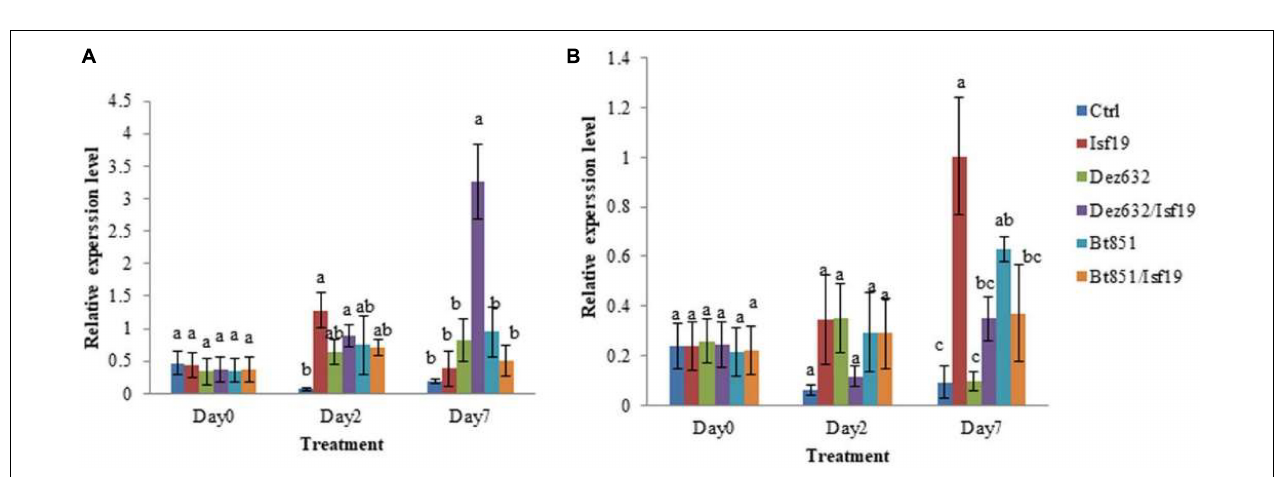
FIGURE 6 | Scanning electron micrographs of Bacillus pumilus Isf19 cells exposed with VOCs produced by Streptomyces sp. B86 and Stenotrophomonas sp. Sh622 strains. Ctrl: non-treated control cells. Arrowheads indicate cell disruption or abnormality.